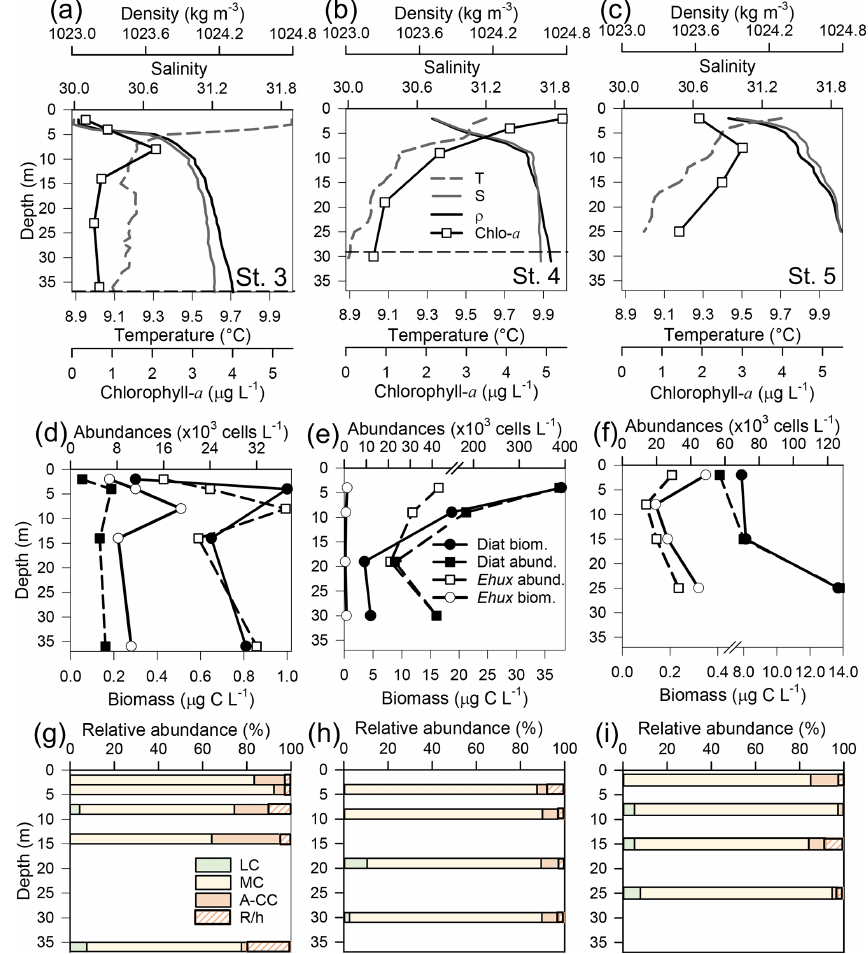
Figure 4. Physical, chemical, and biological vertical profiles recorded in the Archipelago Madre de Dios during late austral spring 2015. Temperature, salinity, density, and total chlorophyll a (a–c) ; abundance and total carbon biomass of E. huxleyi ( Ehux ) and diatoms (Diat; d–f ); and relative abundance of four E. huxleyi morphotypes (g–i) in the W-AMD (St. 3 , a, d, g ), between (St. 4, b, e, h ), and E-AMD zones (St. 5, c, f, i ). Dotted lines in (a–b) indicate depths of 1% PAR penetration (St. 5 was conducted at night). Morphotype abbreviations as in Fig. 3. See Fig. S7 for additional